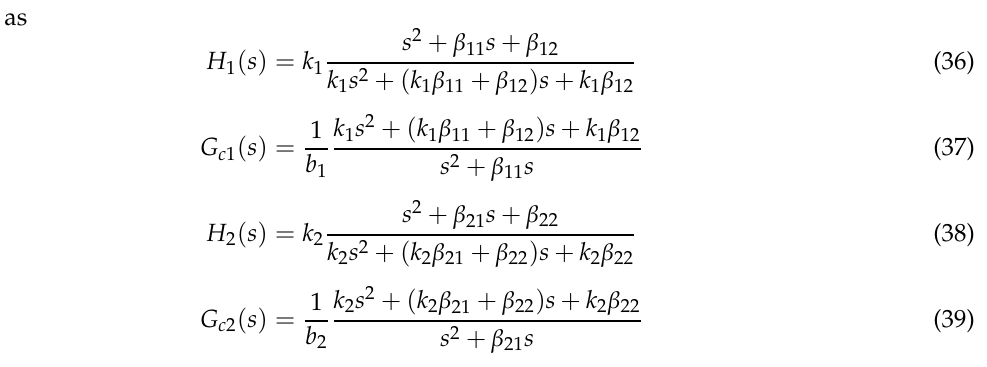
Figure 6. Control structure of boost DC/DC converter.